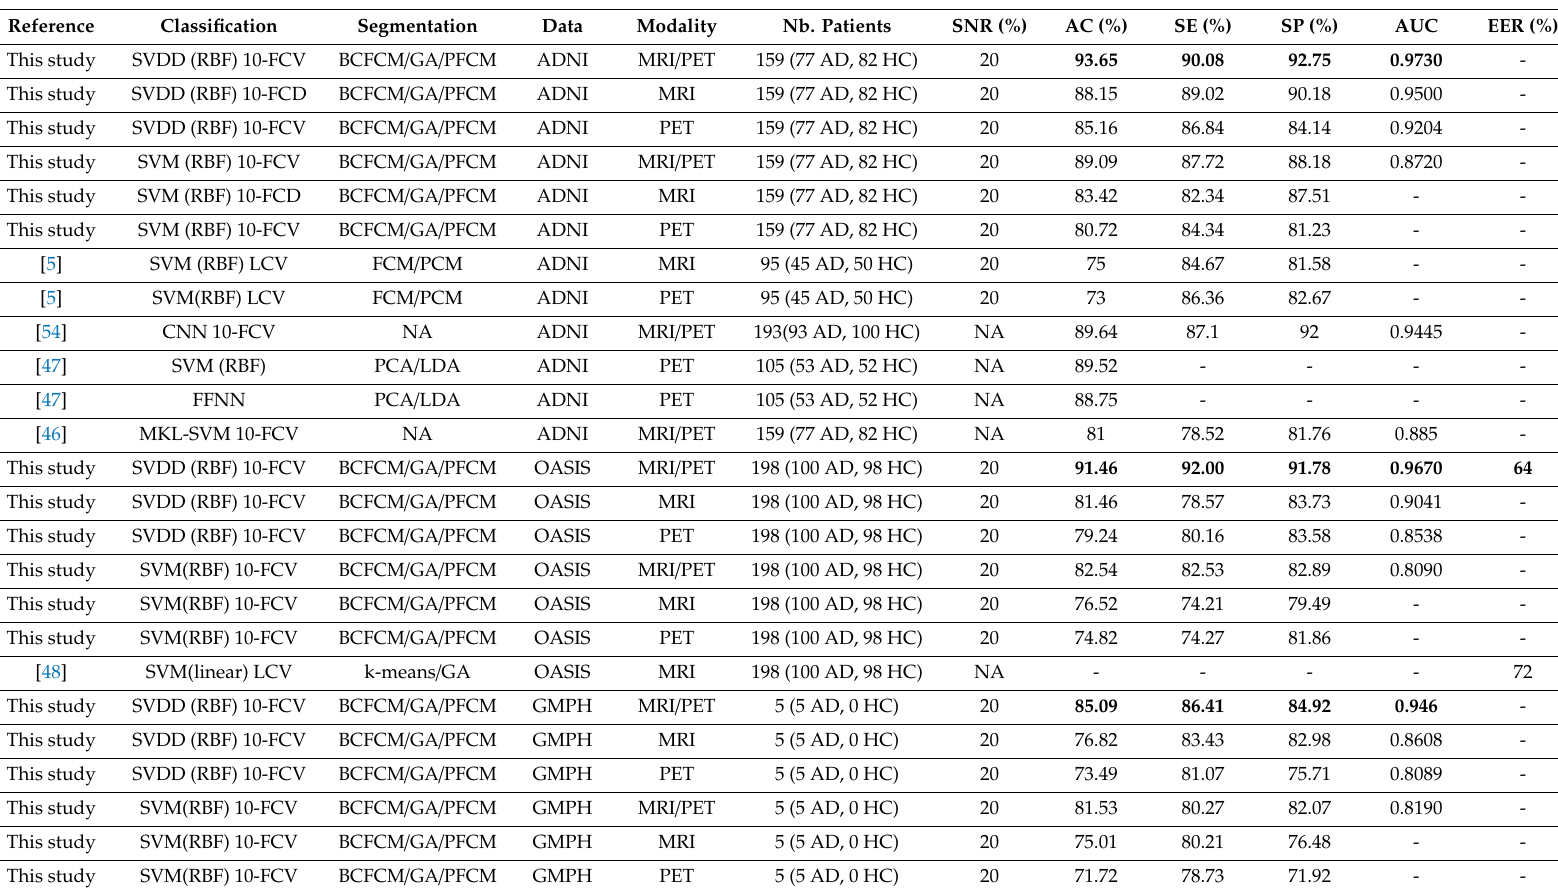
Table 3. Performance of the proposed computer-aided diagnosis (CAD) system for early diagnosis of AD using 10-fold cross validation. Comparison with some systems referenced in the